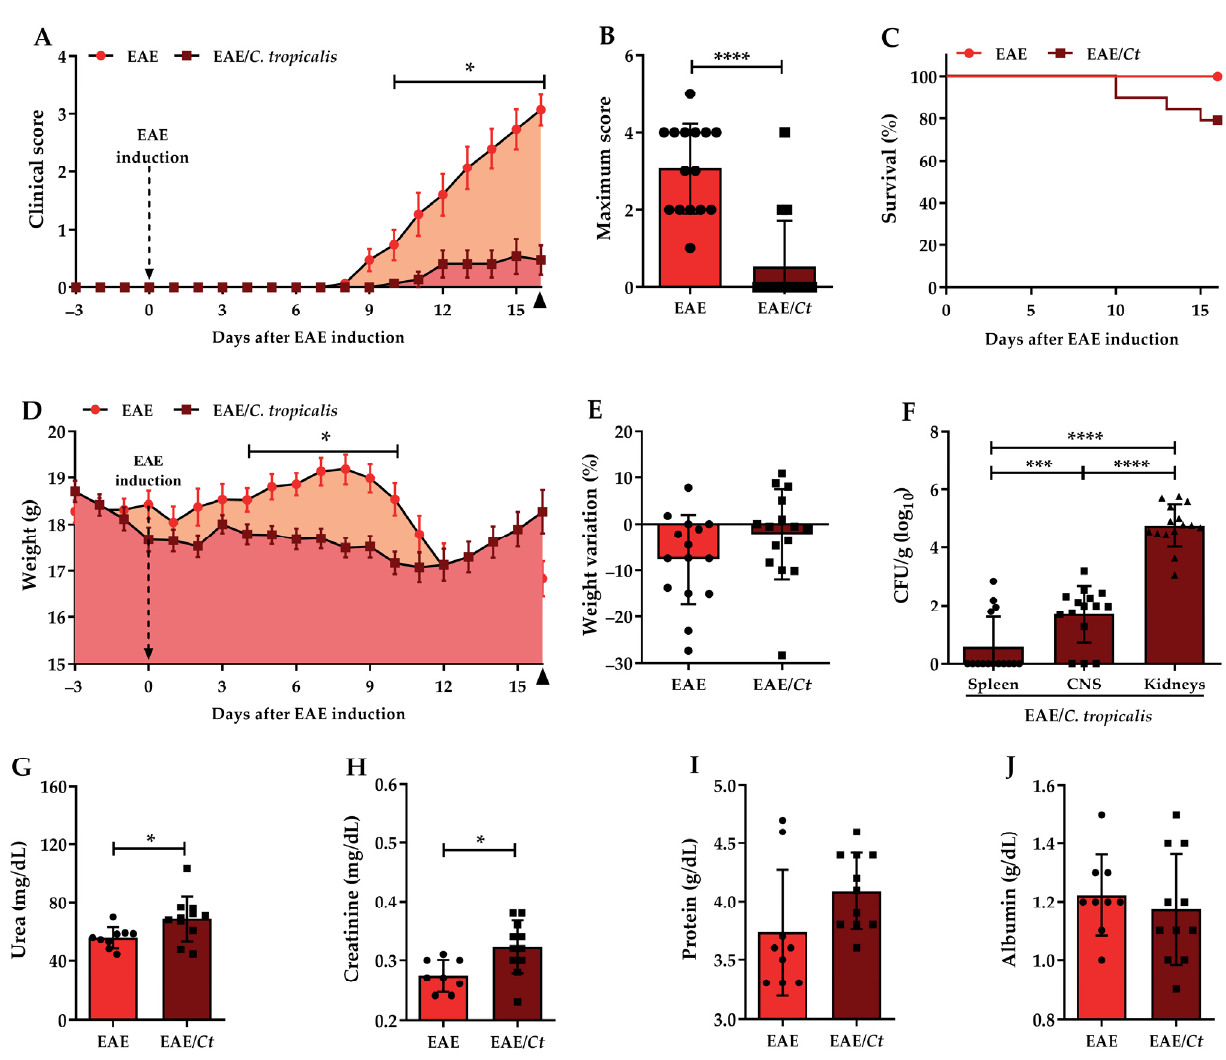
Figure 5. Effect of C. tropicalis infection on EAE development. Female C57BL/6 mice were infected with 1 × 10 6 viable C. tropicalis yeasts three days before EAE induction and evaluated for the daily clinical score ( A ), maximum achieved score ( B ), survival percentage ( C ), daily body weight ( D ), and weight variation percentage considering the initial and the final weight ( E ). The number of colony forming units per gram of tissue (CFU/g) in spleen, CNS, and kidney ( F ) samples and levels of urea ( G ), creatinine ( H ), protein ( I ), and albumin ( J ) were evaluated on the 16th day after EAE induction. The results are expressed as mean ± SD; n = 15/group ( A – F ); n = 9–11/group ( G – J ); three independent experiments; * p < 0.05; *** p < 0.005, and **** p <